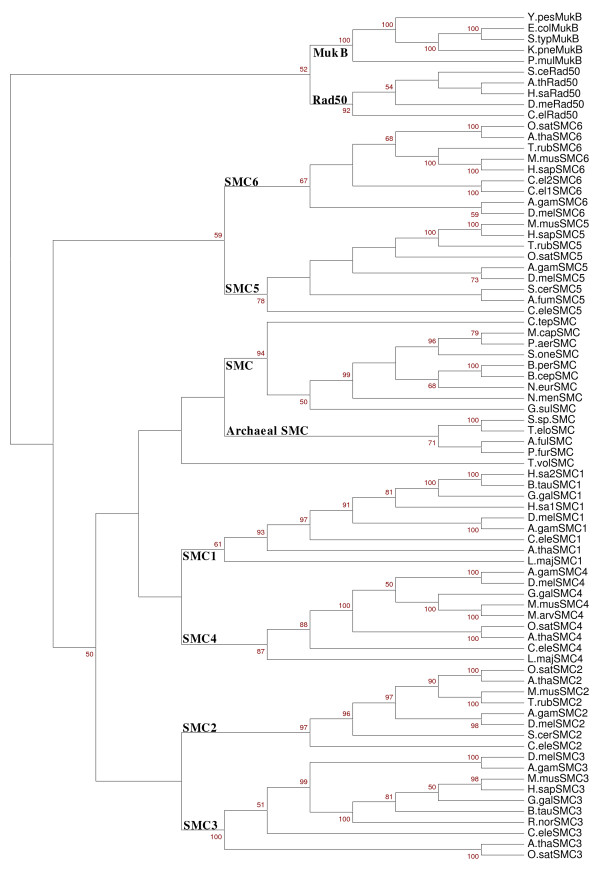
The diagram of phylogenetic relationships. Phylogenetic relationships are obtained by neighbor-joining program based on our statistical distance measure Gdis.k using all six SMC subfamilies, as well as the related MukB and Rad50. Bootstraps are based on 100 replications, and bootstrap values, lower than 50, are hidden.